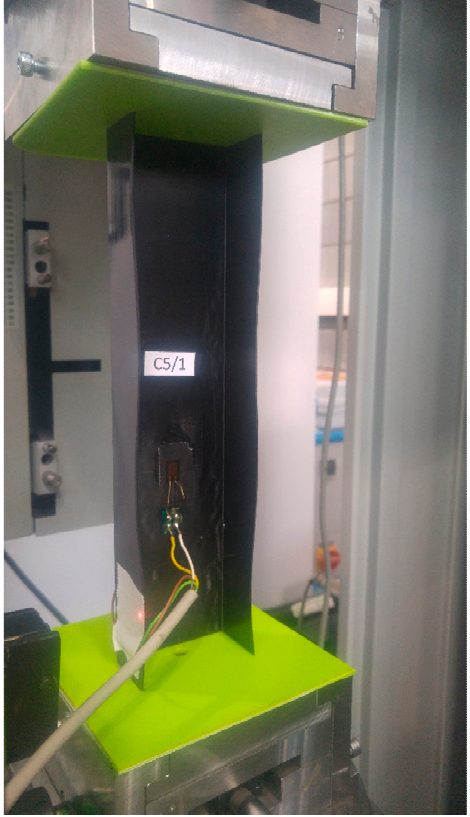
Figure 15. Axial compression test of the 250 mm column and layer configuration [90 / 0 / 90 / Table 5. The values of the critical buckling forces predicted by the artificial neural networks with the values obtained using the finite element and experimental methods.